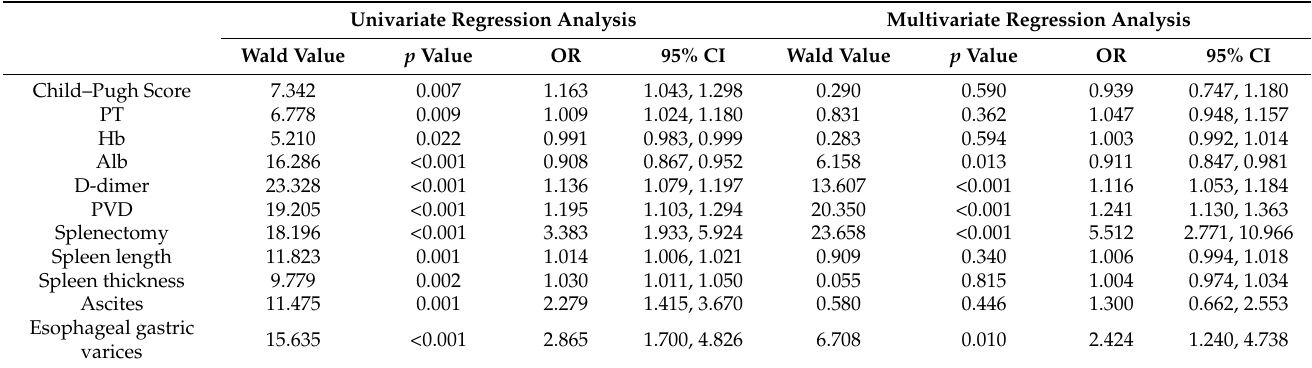
Table 2. Univariate and multivariate regression analysis in the training cohort.